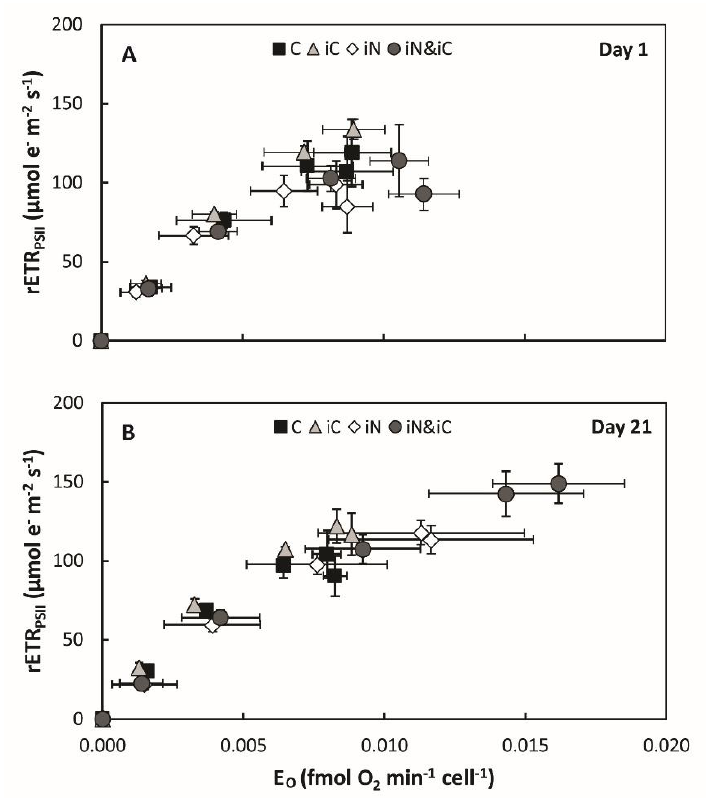
Figure 4. Comparison of the relative electron transport rate through PSII (rETR PSII ; µ mol e − m − 2 s − 1 ) and gross O 2 evolution by PSII (E O ; fmol O 2 min − 1 cell − 1 ) at steady-state photosynthesis in S. pistillata , after 1 day ( A ) and 3 weeks ( B ) of exposure to natural seawater (control) and to seawater enriched with 6 mM HCO 3 − ( + iC) or 4 µ M NH 4 + ( + iN) or both ( + iC & iN). Measurements were conducted at 0, 70, 150, 300, 600 and 900 µ mol photons m − 2 · s − 1 and data are presented as mean ± SD ( n = 6).